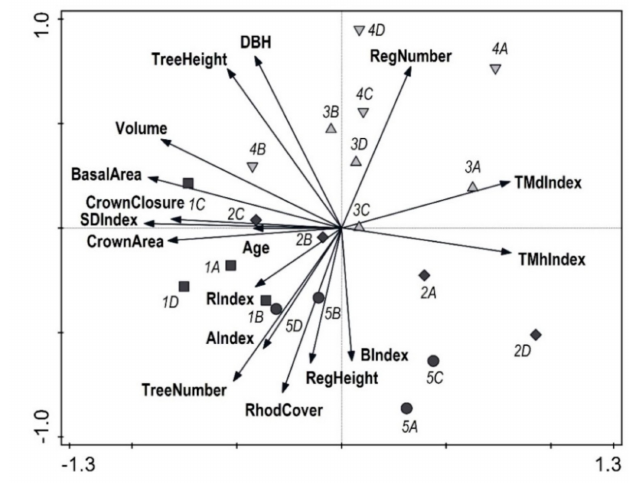
Figure 8. Ordination diagram showing results of unconstrained principal component analysis of relationships between stand parameters ( Age —mean stand age, DBH —quadratic breast height diameter, Tree Height —mean stand height, Volume— of stand, Tree Number , Basal Area, Crown Closure, Crown projection area , and SD index — stocking), natural regeneration parameters ( RegNumber and RegHeight ), rhododendron cover ( RhodCover ), and diversity indices of tree layer ( R— aggregation